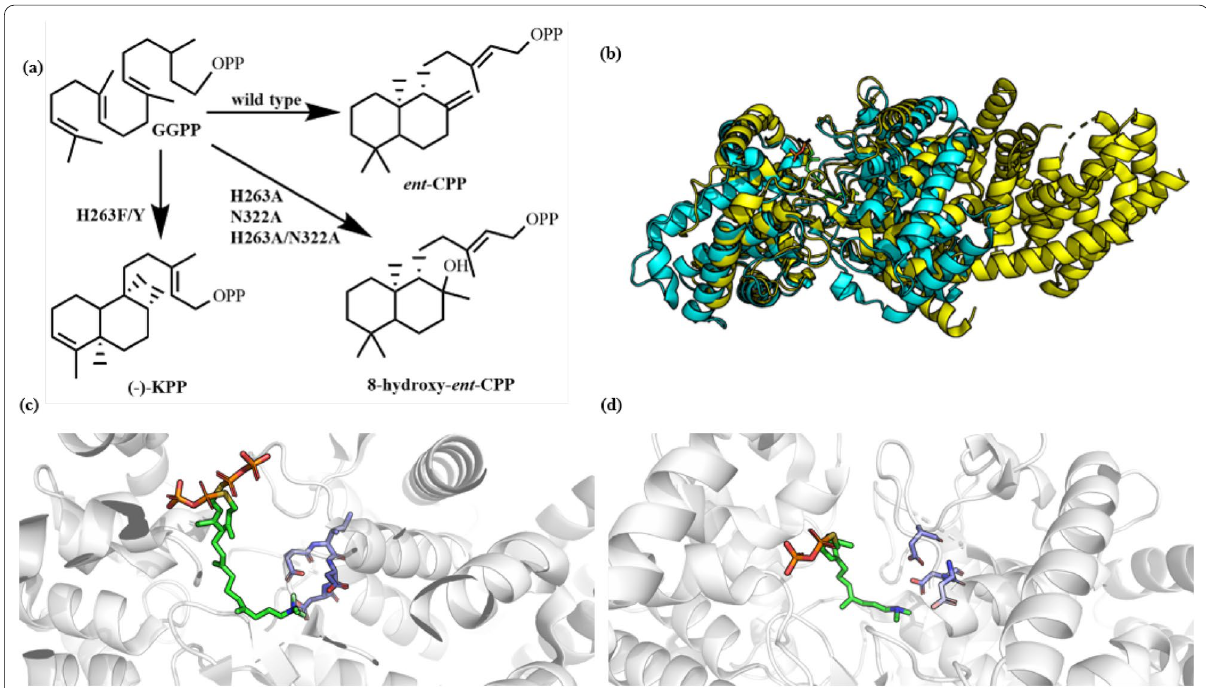
Fig. 18 a Products of At CPS and its mutants. b Superposition of ent ‑copalyl diphosphate synthase from Arabidopsis thaliana ( At CPS) in complex with ( S )‑15‑aza‑14,15‑dihydrogeranylgeranyl thiolodiphosphate (PDB ID: 4LIX , yellow) and ent ‑copalyl diphosphate synthase from Streptomyces platensis ( Sp CPS) (PDB ID: 5BP8 , blue). c Active sites of At CPS in complex with ( S )‑15‑aza‑14,15‑dihydrogeranylgeranyl thiolodiphosphate (PDB ID: 3PYA ). d Active sites of At CPS in complex with ( S )‑15‑aza‑14,15‑dihydrogeranylgeranyl thiolodiphosphate (PDB ID: 4LIX ). The substrate analogues and DXDD motif are shown in